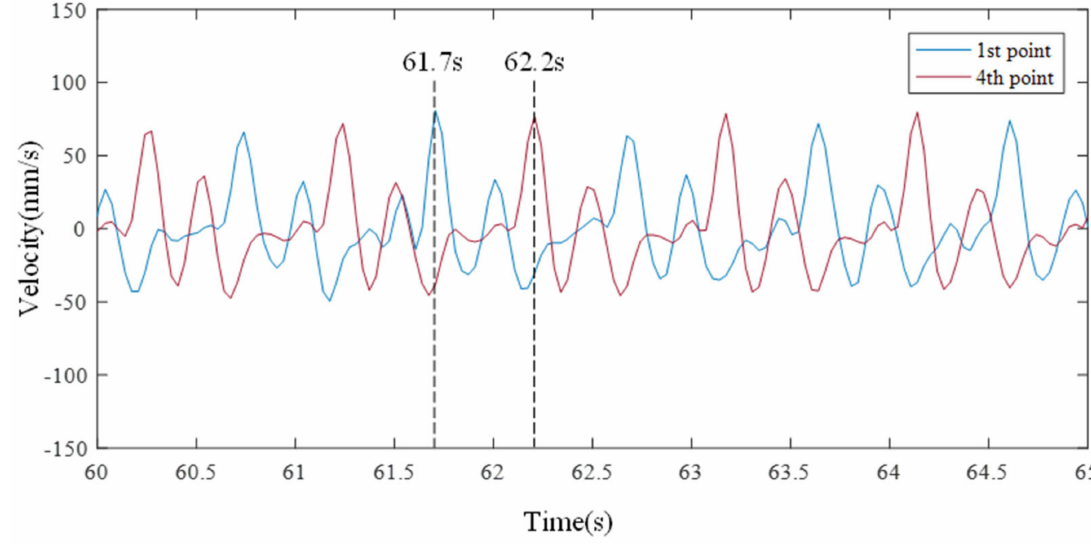
Figure 13. Propagation waves occur due to vibrations close to natural frequencies.